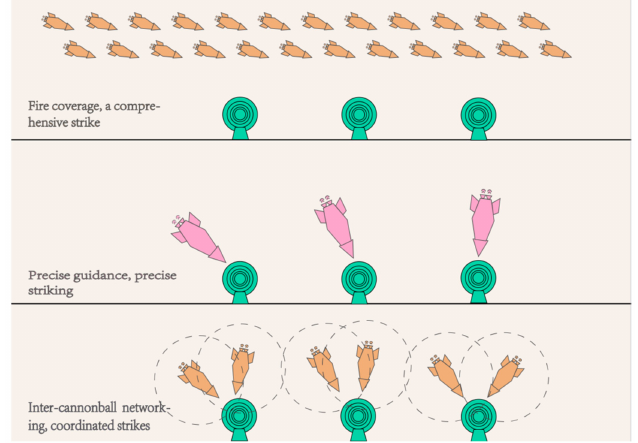
Figure 1. Comparison chart of striking